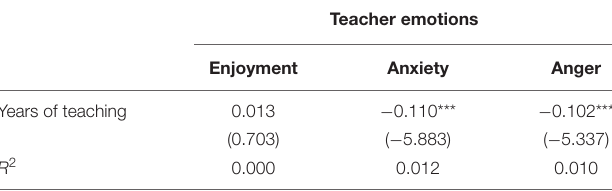
TABLE 3 | Links between teaching experience and three teacher emotions.